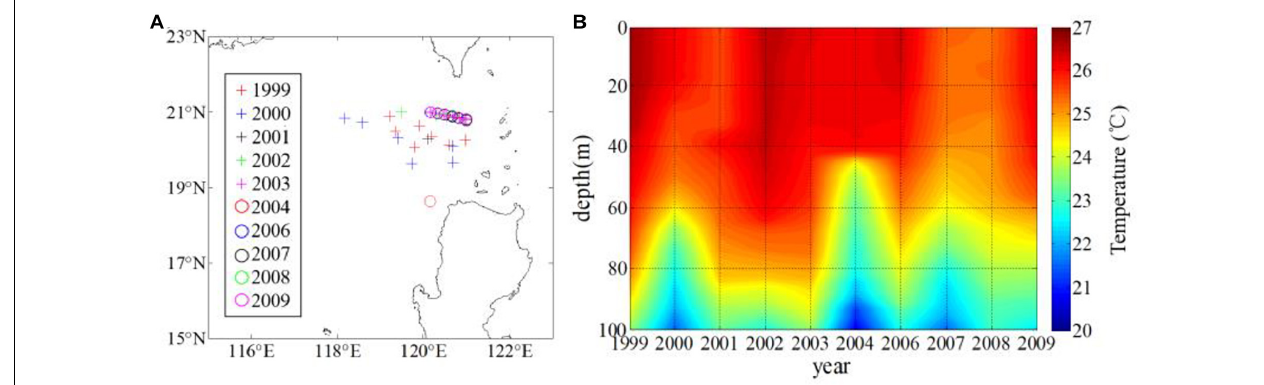
FIGURE 7 | (A) Location of selected XBT set and (B) profile of temperature in the upper 100 m in winter.